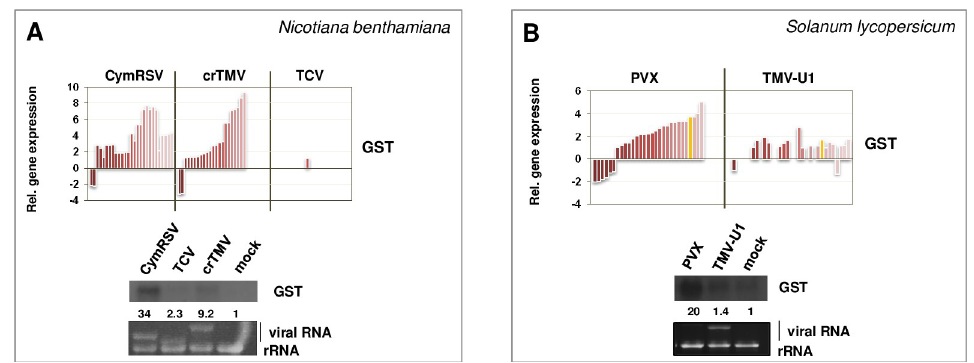
Fig 4. Investigation of the gene expression changes of GST in virus-infected N . benthamiana (A) and S . lycopersicum (B) plants. The column diagram shows log2-fold changes of probes or genes specific for GST obtained by microarray analysis ( N . benthamiana ) or by RNA-seq ( S . lycopersicum ) (upper panels). The lower panel shows Northern blot hybridization using radioactively labelled GST-specific probe. Fold-change values are shown below each band (quantifications were normalized to mock controls). The EtBr-stained gel served as a loading control. Yellow columns depict genes whose levels were validated by Northern blot hybridization. (The investigated N . benthamiana GST probe was absent on the microarray chip).